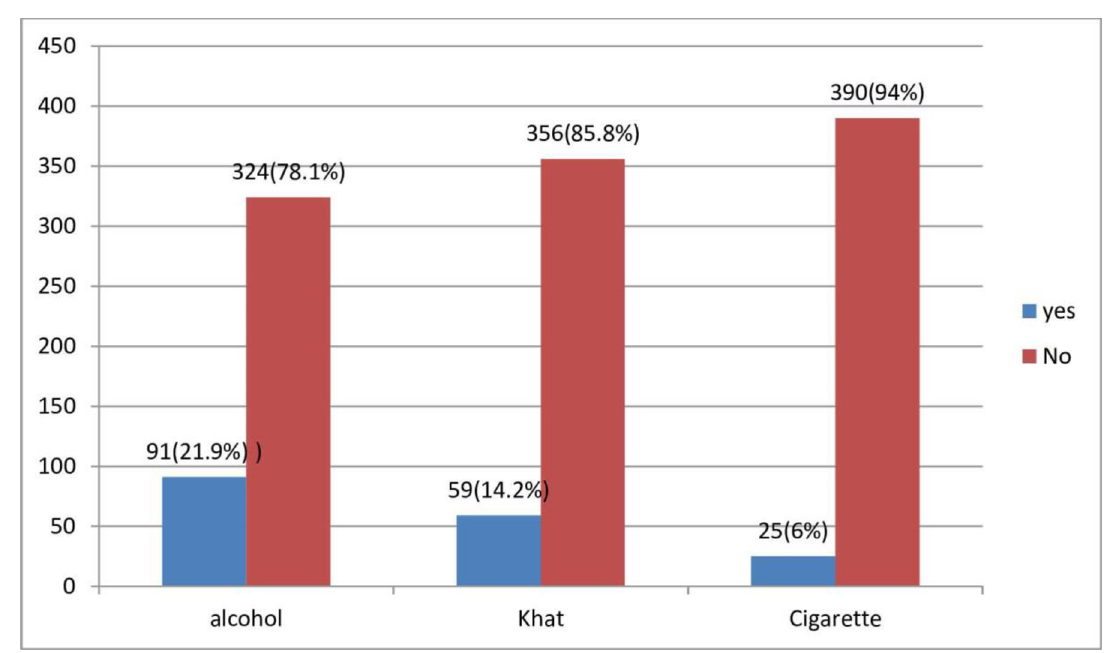
Fig 1. Current substance use characteristics of participants. ! NB : - No other addictive substances were reported.